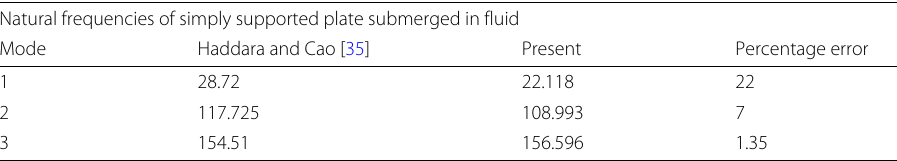
Table 3 Validation of solution for fluid-plate interaction Natural frequencies of simply supported plate submerged in fluid Mode Haddara and Cao [35] Present Percentage